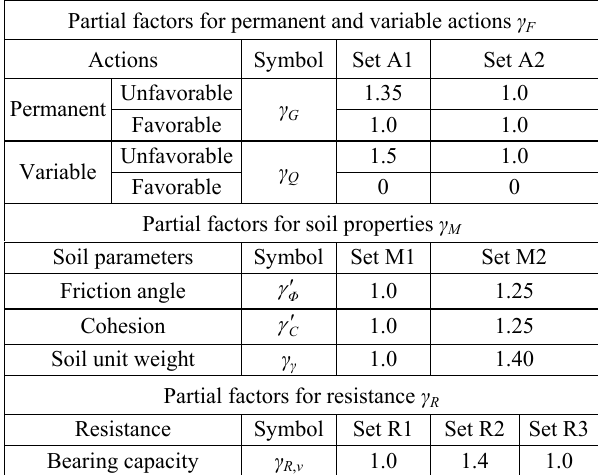
Table 1. Partial safety factors established by